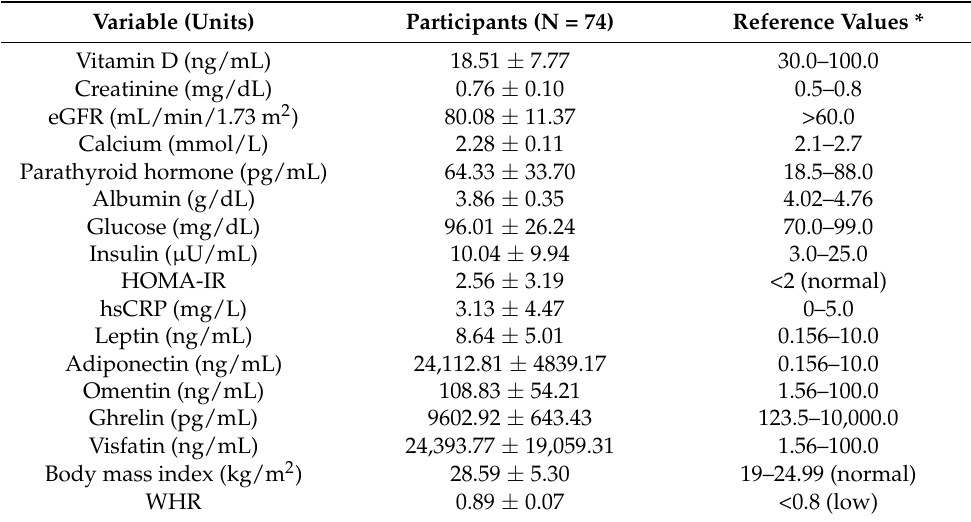
Table 1. Biochemical and anthropometric characteristics of